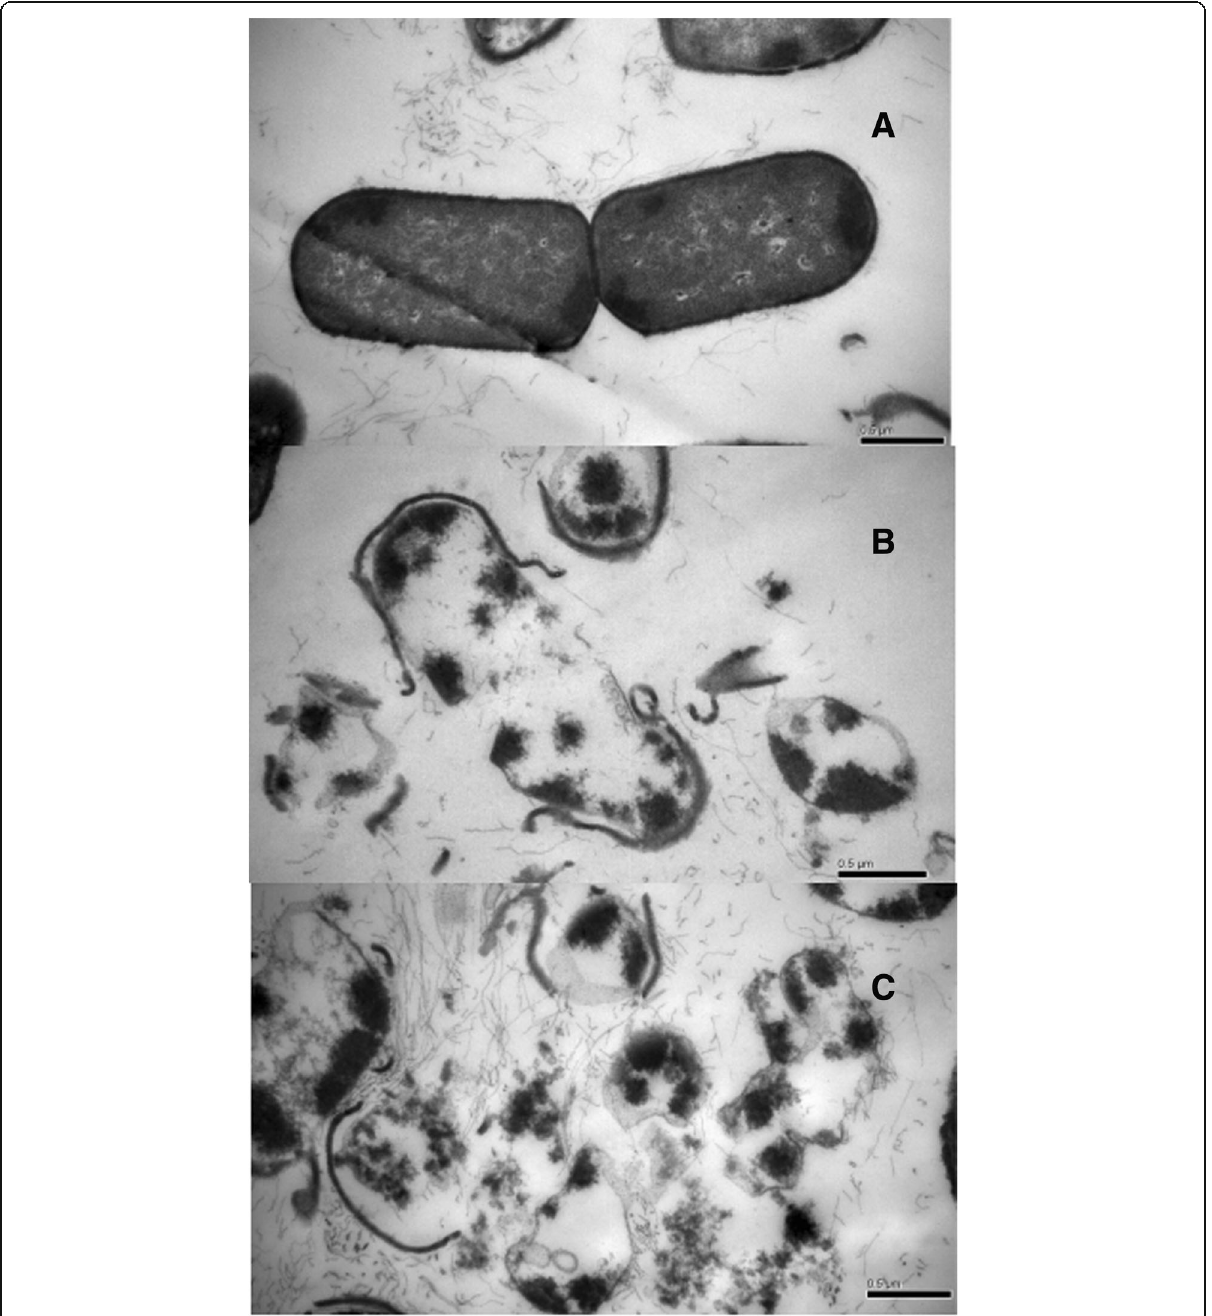
Fig. 5 The morphological alterations of F. nucleatum cells treated with different concentrations of ATS-80. ATS-80, 80% methanol-eluted fractions from alkali-treated quinoa saponin; a , control; b , minimum inhibition concentration; c , minimum bactericide